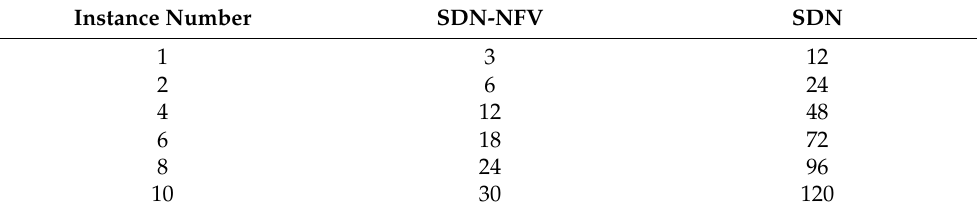
Table 15. Comparison of measurement times of adding EPG and port-group.